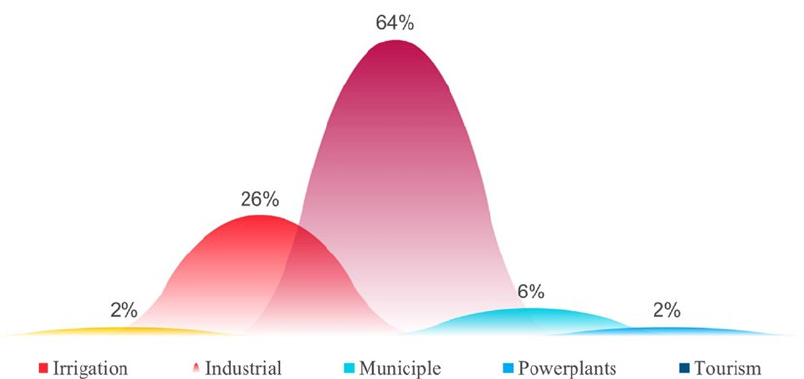
Figure 1. The percentage of the world ’ s desalinated water supply used by each country ’ s total installed desalination capacity.